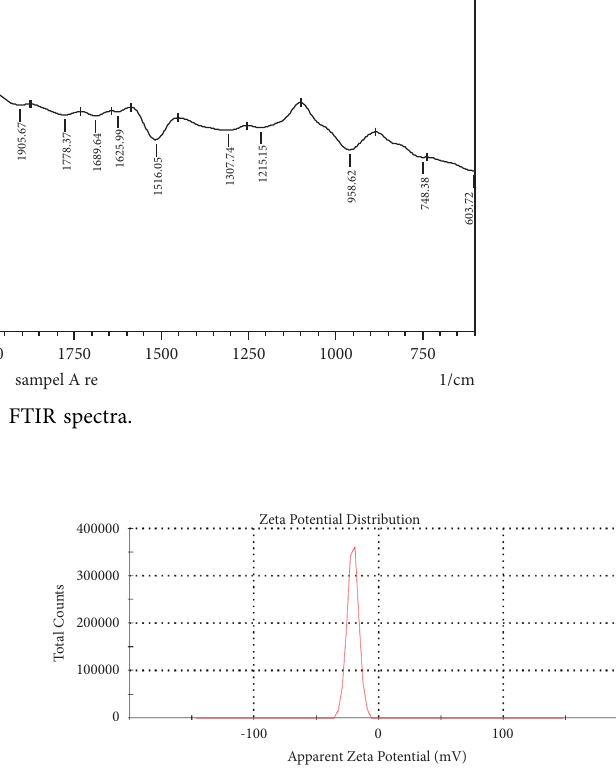
Figure 6: Zeta potential for CSAC.